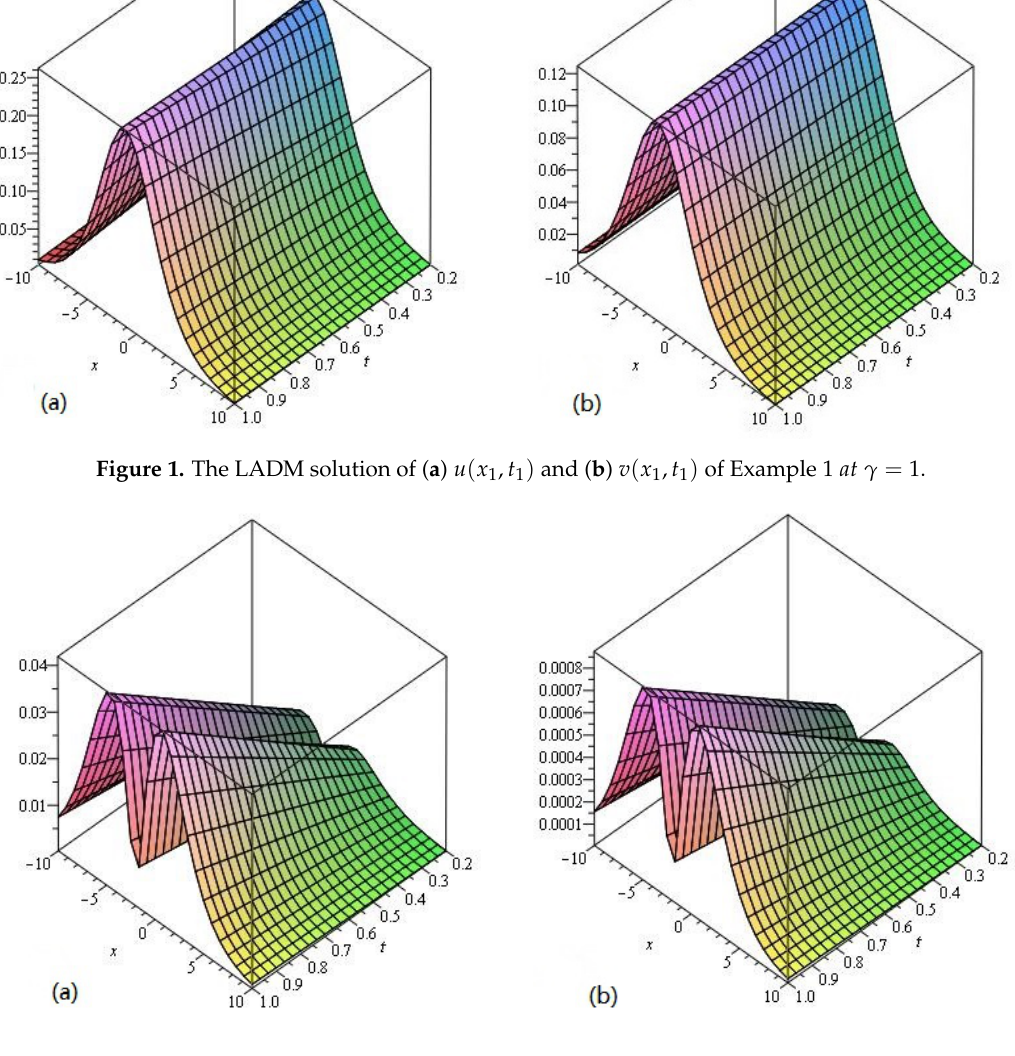
Figure 2. The error plots of ( a ) u ( x 1 , t 1 ) and ( b ) v ( x 1 , t 1 ) of Example